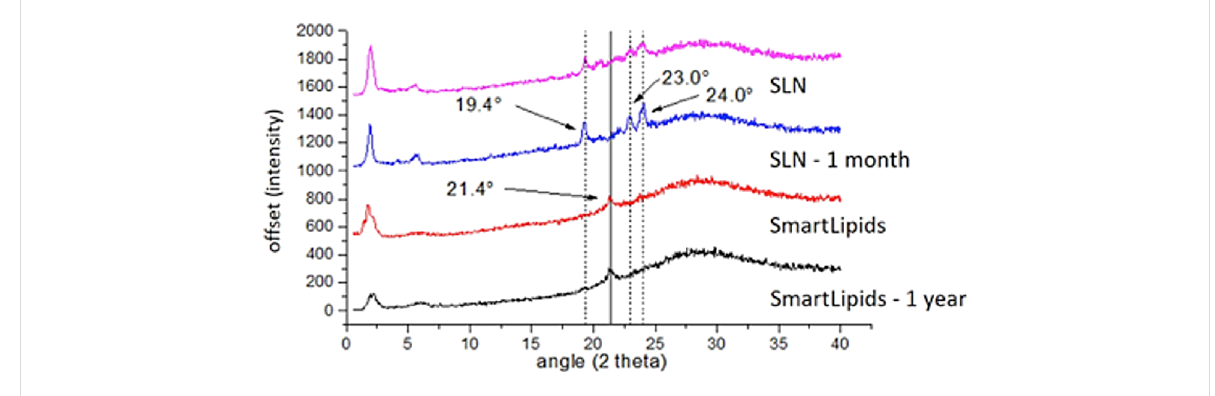
Figure 3: X-ray diffraction patterns of SLNs (pink curve) and SmartLipids mixture (red curve) determined directly after production and after one month (SLNs: blue curve) and one year (SmartLipids: black curve) storage at room temperature [5].